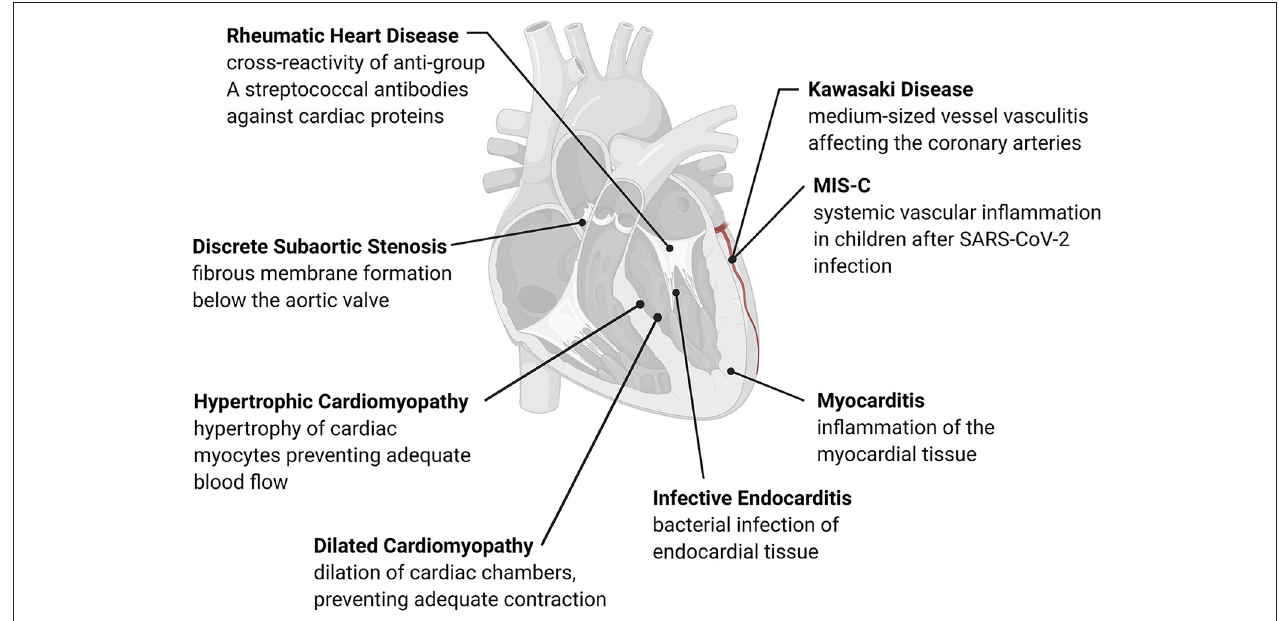
FIGURE 1 | Overview of acquired pediatric heart disease. Acquired pediatric heart diseases can arise as a reaction to various stresses, including flow differences, structural changes, or pathogens. The development of many of these conditions has an immune or inflammatory trigger that causes remodeling of the cardiac structures or activation of native immune cells. Many of these conditions are progressive, leading to long-term complications such as valve damage, fibrosis, and adverse cardiac